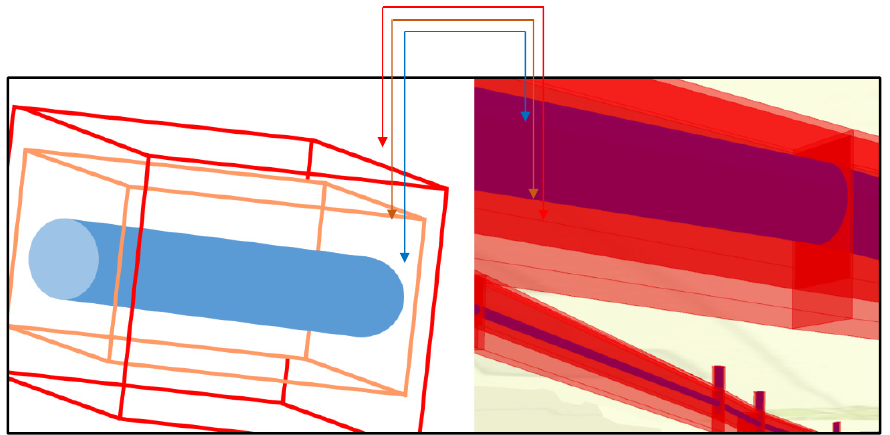
Figure 13. Water pipeline networks primary/secondary in Cornavin undergrounds, concep- tual/visual.